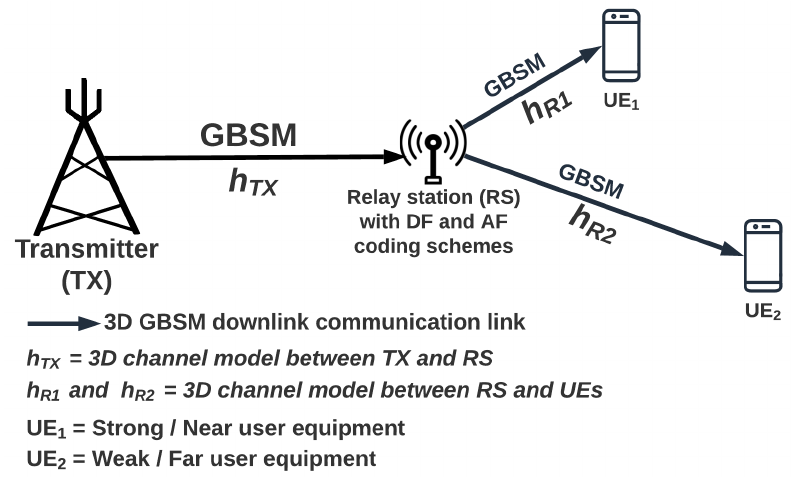
Figure 3. Proposed model of the downlink cooperative relay NOMA network with